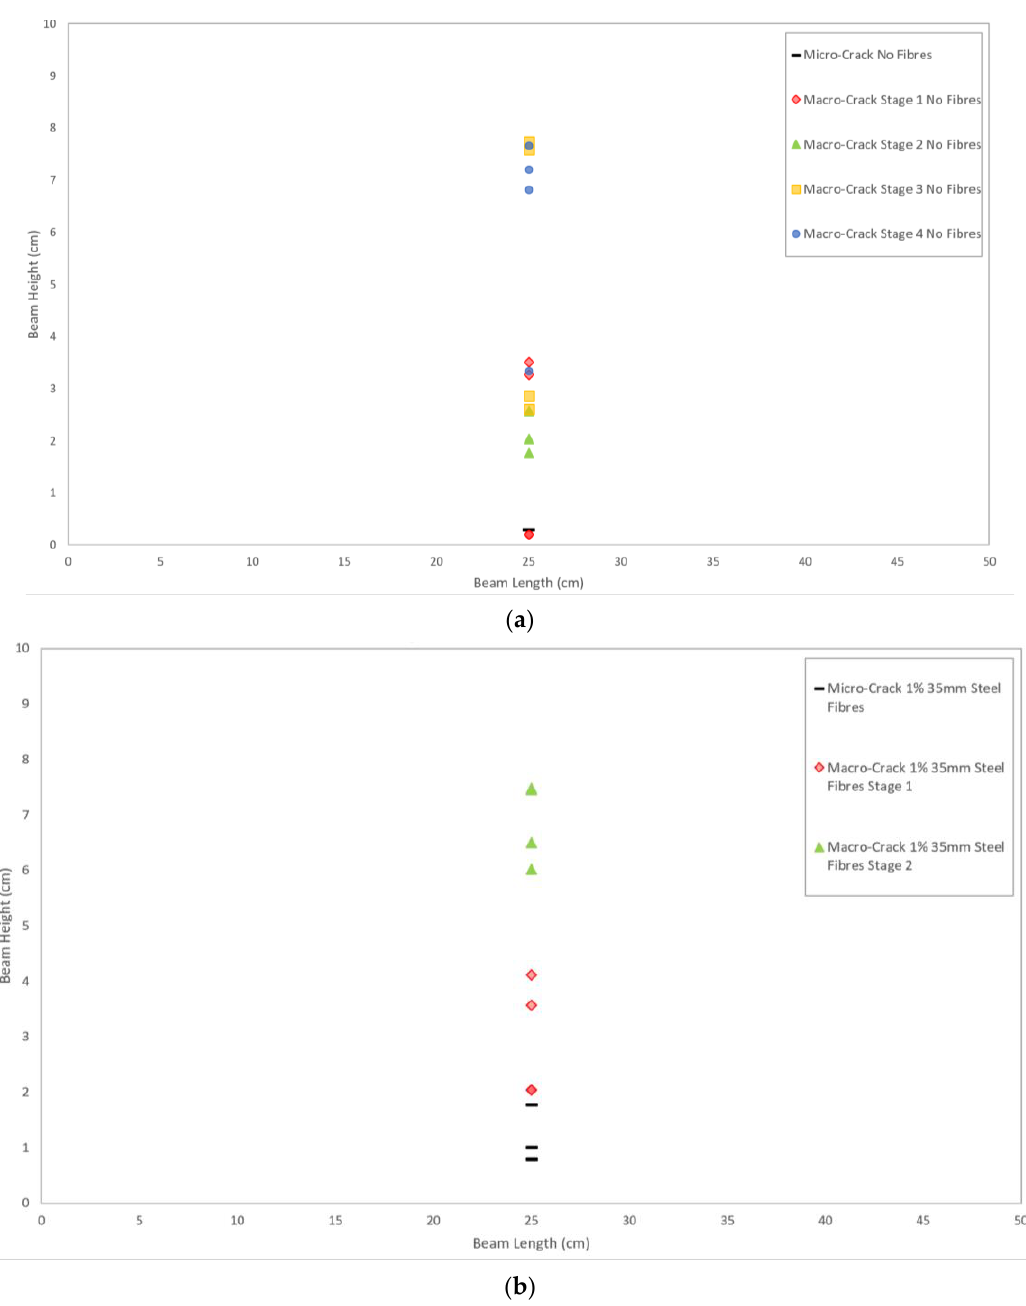
Figure 12. Crack location trace for: ( a ) plain SCC, and ( b ) SFRSCC beams.